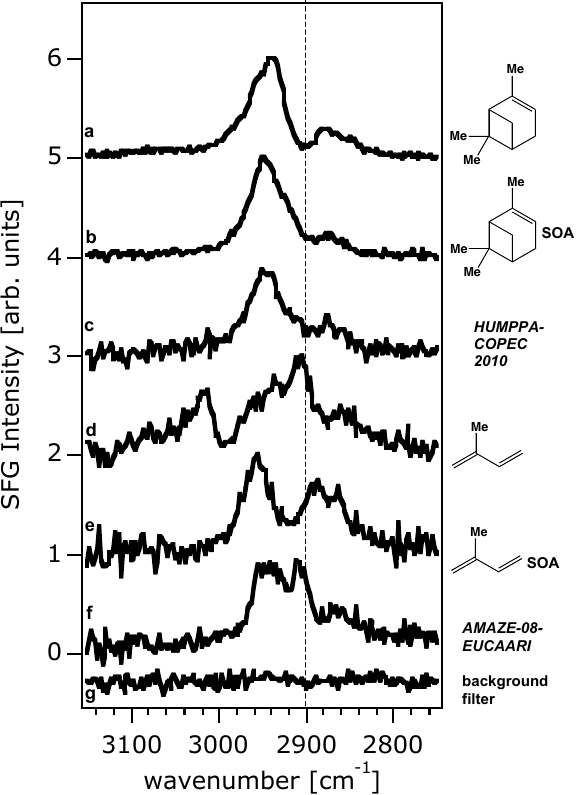
Fig. 3. SSP-Polarized vibrational SFG spectra of an optical win- dow in contact with (a) the equilibrium organic vapor at room temperature of α -pinene; (b) secondary organic particle material produced from α -pinene in the Harvard Environmental Chamber (HEC); (c) a Teflon filter containing aerosol particles with diame- ters below 1µm collected in Southern Finland during the HUMPPA- COPEC-2010 field intensive; (d) the equilibrium organic vapor at room temperature of isoprene; (e) isoprene-derived secondary or- ganic aerosol particle material produced at the HEC; (f) a fused silica window which had been pressed against impactor substrates containing aerosol particles with diameters below 1µm collected in the central Amazon Basin during the 2008 wet season; and (g) of a Teflon filter placed after a HEPA filter during the outflow of α -pinene-derived secondary organic aerosol particles produced at the HEC. All spectra normalized to the highest peak intensity, and offset for clarity. The vertical dashed line at 2900cm − 1 dissects the frequency location of asymmetric and symmetric CH stretching modes of aliphatic hydrocarbon species to the left and right of it, respectively.